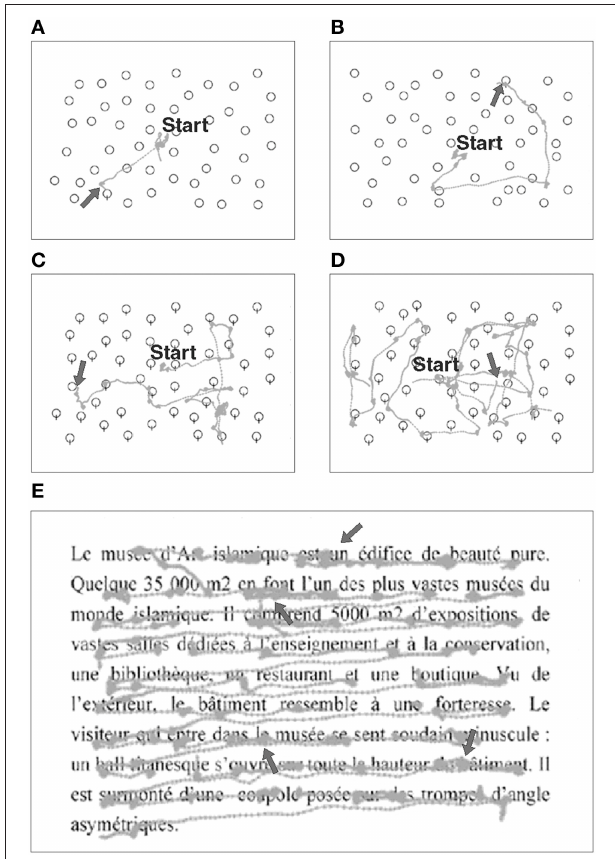
FIGURE 3 | Examples of eye movement recordings during visual exploration and reading tasks in a patient (#8) with right-HVFD. Gray traces represent raw eye movements performed by the patient. In the Pop-out (A,B) and Serial (C,D) exploration tasks, arrow signals the endpoint of the saccade made to the target. When the target is in the healthy hemifield ( A,C ) fewer exploration saccades are made as compared to when the target is in the blind hemifield ( B,D ). In the reading task (E) , arrows point to the typical oculomotor deficits of right HVFD patients, i.e., smaller saccades with higher rate of